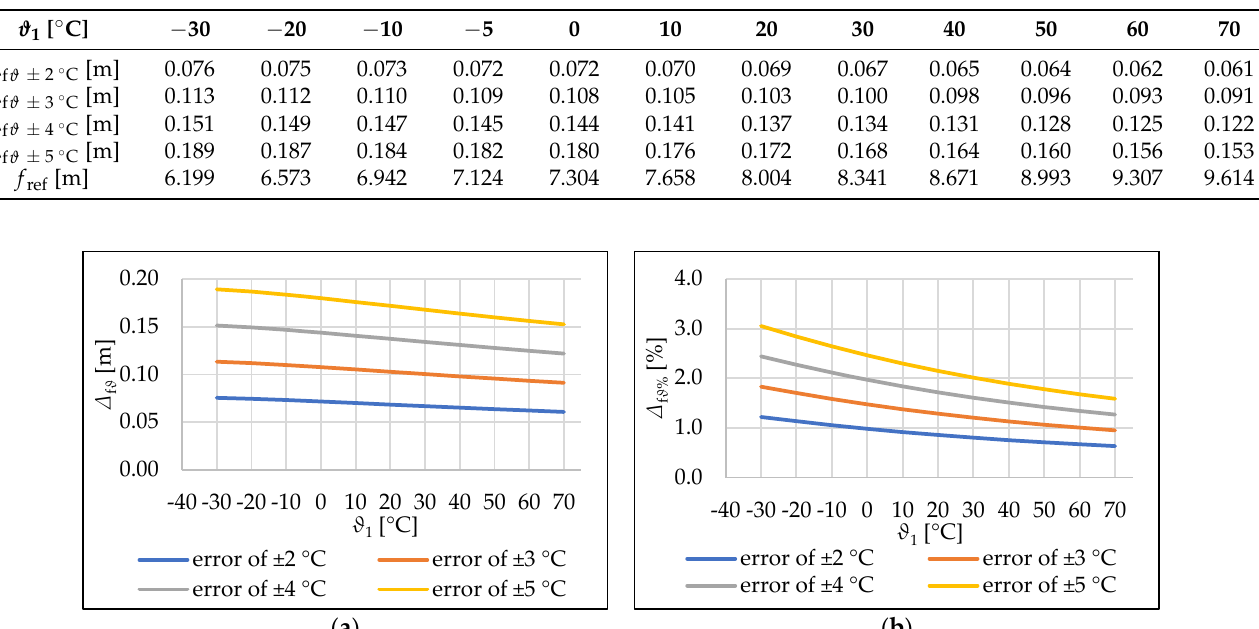
Table 3. Maximum absolute sag deviations Δ f ϑ caused by the incorrect determination of the initial conductor temperature by ±2 °C, ±3 °C, ±4 °C and ±5 °C.